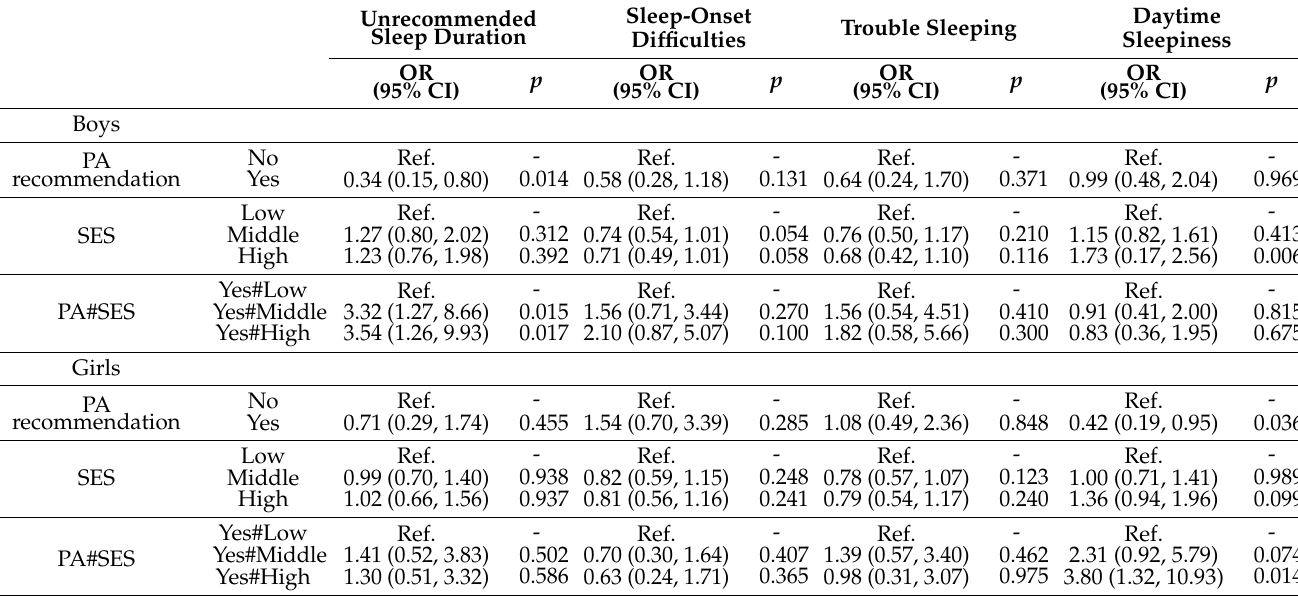
Table A2. Interaction between PA and SES stratified by sex (logistic regression models; all models adjusted for: screen time, emotional and behavioral problems, personal resources,